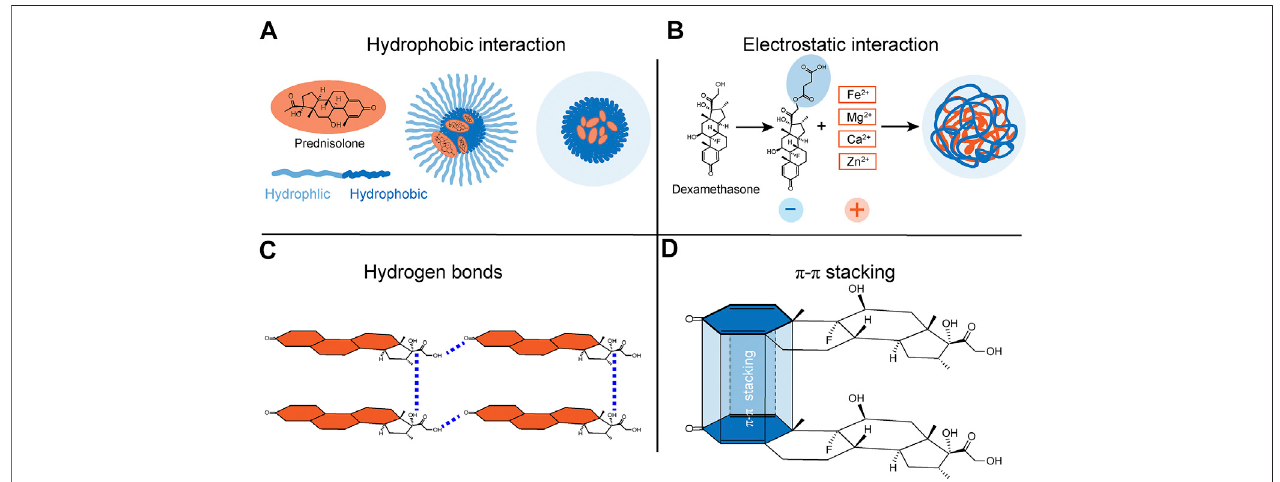
FIGURE 1 | Schematic representations of possible interactions between supramolecular materials and steroids. The supramolecular materials bind to steroids possibly via (A) hydrophobic interactions, (B) electrostatic interactions, (C) hydrogen bonds, and (D) π - π stacking interactions.